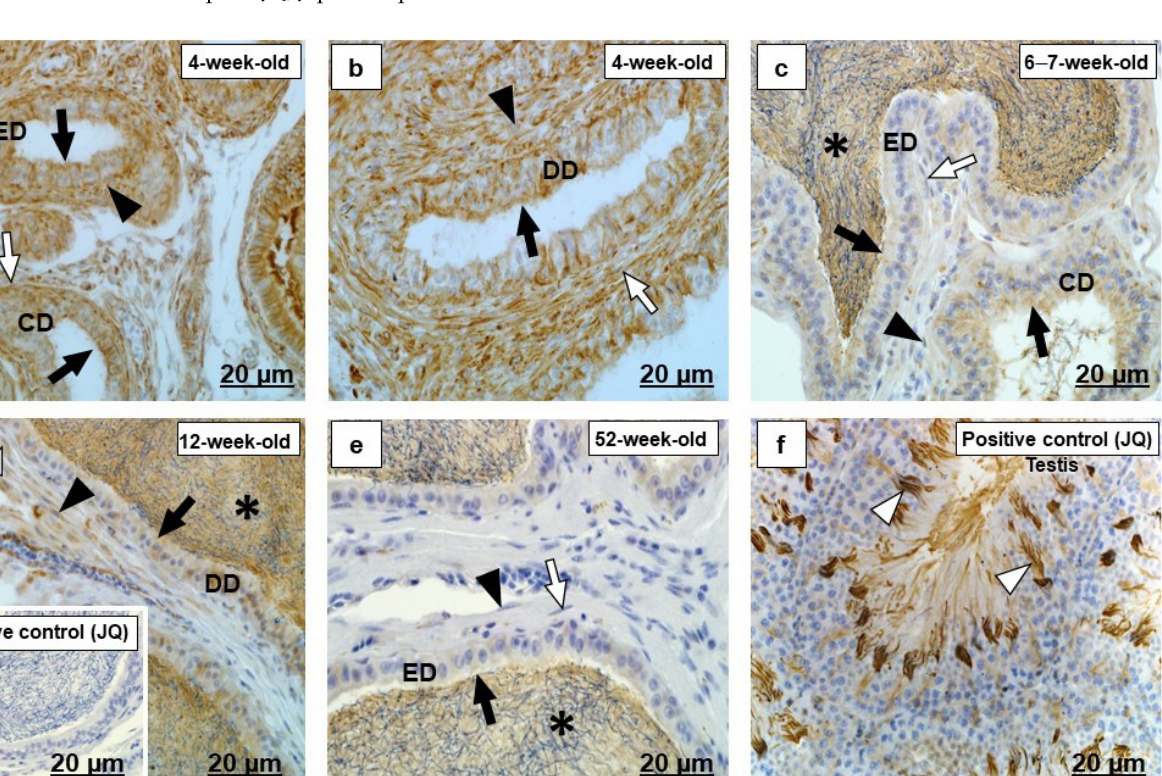
(black arrowhead). ( b ) Moderate to strong immunostaining in the periductal smooth muscle cell (white arrowhead) and fibroblasts (black arrowheads). ( c ) Moderate to strong immunostaining in the epithelium (black arrows) of the RT. Moderate immunostaining in the vascular endothelial cells (white arrowhead). Weak immunostaining in the tunica media of interductal blood vessel (bracket). ( b , d , e , g ) White arrows depict strong immunostaining in the cilia. ( b , d , e ) Moderate to strong immunostaining in the lateral and subapical regions of cells (black arrows) lining the PED and DED. ( d , e ) Weak immunostaining in the periductal smooth muscle cell layers (white arrowheads) and fibroblasts (black arrowheads). ( f ) Weak to moderate immunostaining in the RT epithelium (black arrows) and the vascular endothelial cells, and tunica media (black arrowhead). ( g ) Weak immunostaining in the epithelium (black arrows), periductal smooth muscle layers (brackets) and fibroblasts (black arrowheads) of the PED and DED. ( h ) Negative control: Efferent ducts of an adult Japanese quail. ( i ) Positive control: Immunopositive sperm (asterisks) in the testis of an adult Japanese quail. JQ, Japanese quail.